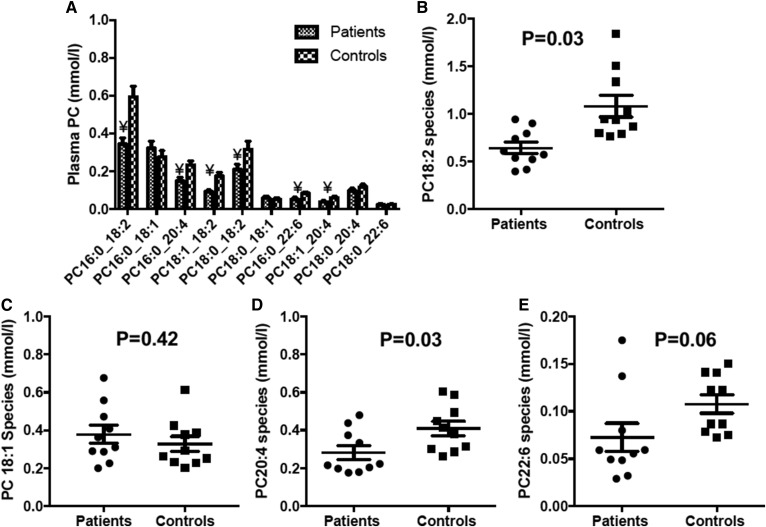
Concentration of selected plasma PC molecular species at enrollment (t = 0). A: Mean distribution of PC species. Error bars indicate SEM. Statistical analysis unpaired Student’s t-test. ¥, P < 0.05. B–E: Scatter plots to illustrate the variation and differences between patient and control groups for selected major (>2% presence) PC species containing 18:2 (B), PC18:1 (C), PC20:4 (D), and PC22:6 (E).